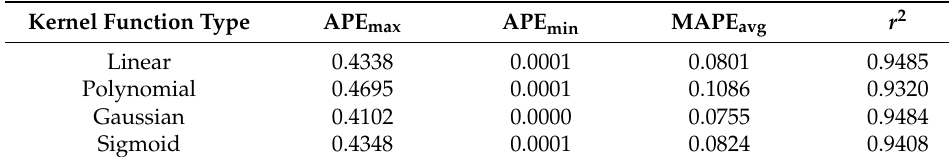
Table 4. The average forecasting performance of the test set.